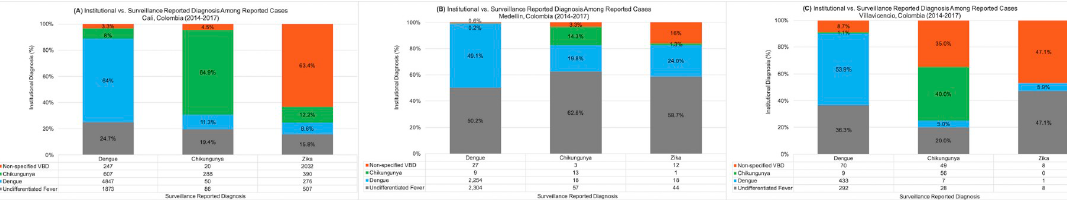
Fig 1. Agreement between health care facility’s diagnosis and SIVIGILA’s notified diagnosis of arboviral diseases in Colombia (2014– 2017). Fig 1A: Healthcare facility’s diagnosis and SIVIGILA’s reporting in Cali. Fig 1B: Healthcare facility’s diagnosis and SIVIGILA’s reporting diagnosis in Medellin. Fig 1C: Healthcare facility’s diagnosis and SIVIGILA’s reporting diagnosis in Villavicencio. Non-Specified Vector-Borne Diseases (Non-specified